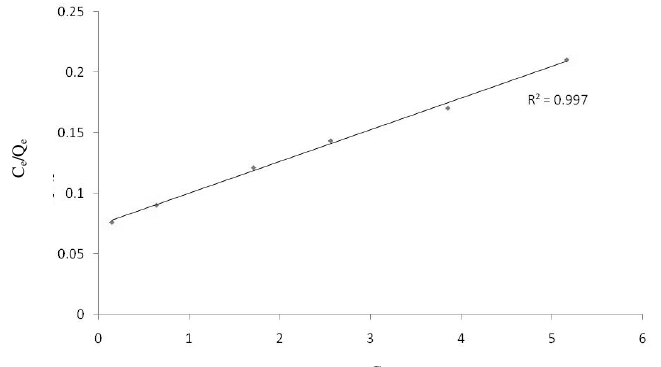
Figure 4. Langmuir adsorption isotherm of RHD dye onto